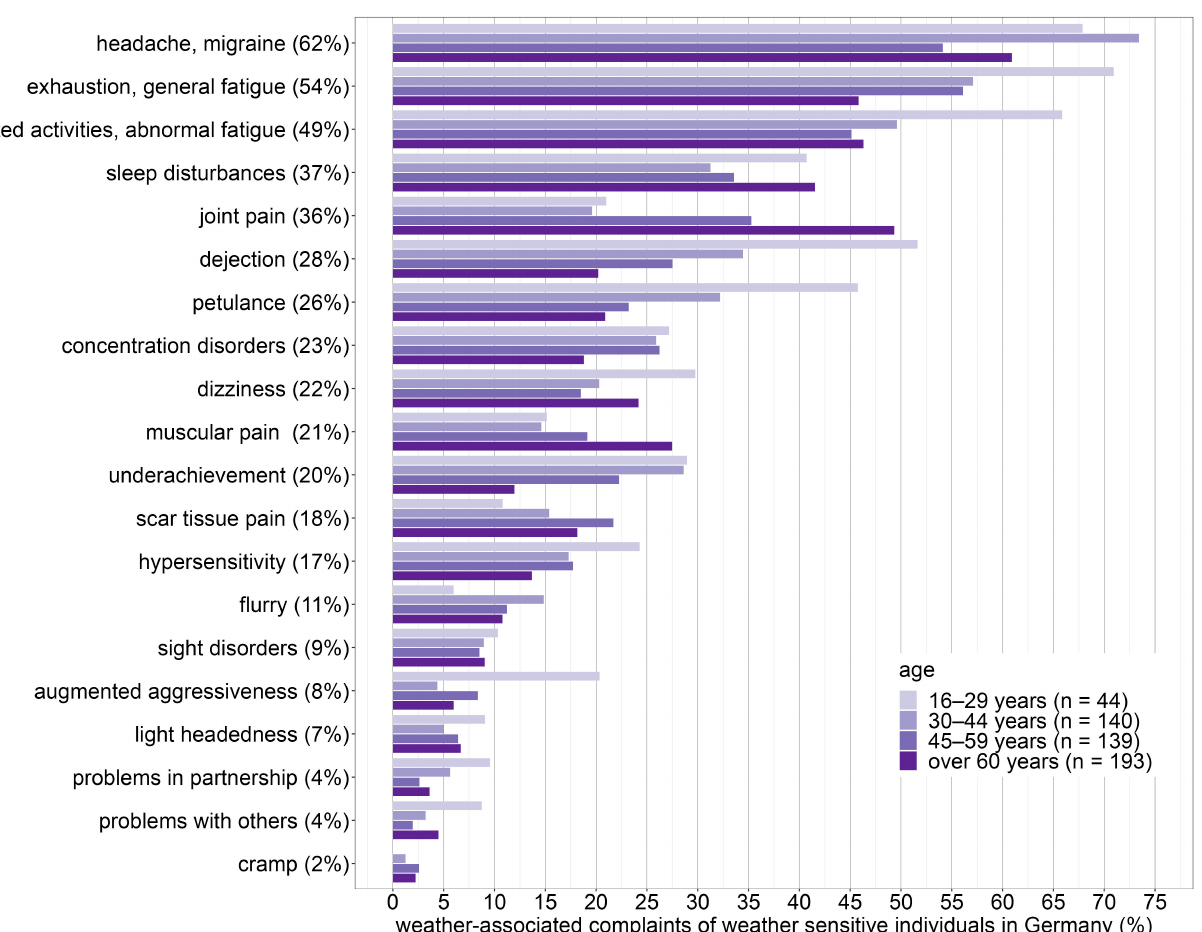
Figure 3. Percentage of weather-associated complaints and symptoms per age group that occur among weather-sensitive individuals in Germany. The percentages depicted in parentheses occur irrespective of age group. Multiple responses were possible during the survey. The data are based on representative surveys conducted by IfD Allensbach in January 2021 (self-assessment by respondents).